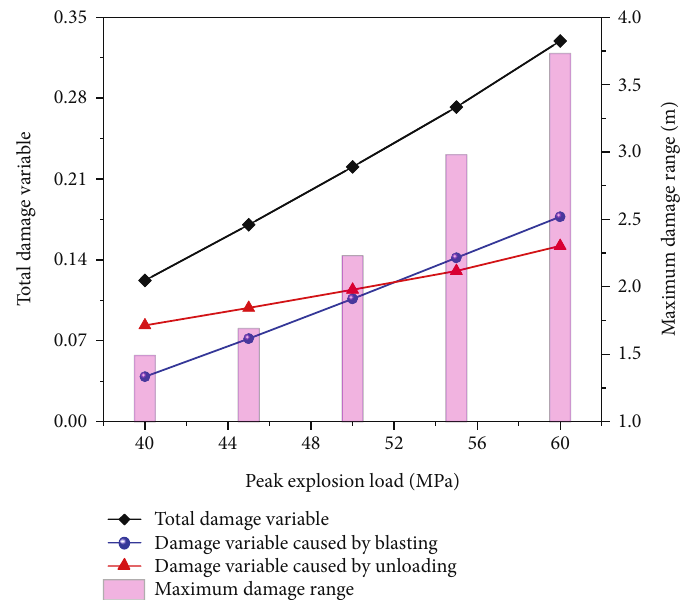
Figure 7: Damage of surrounding rock under di ff erent explosion